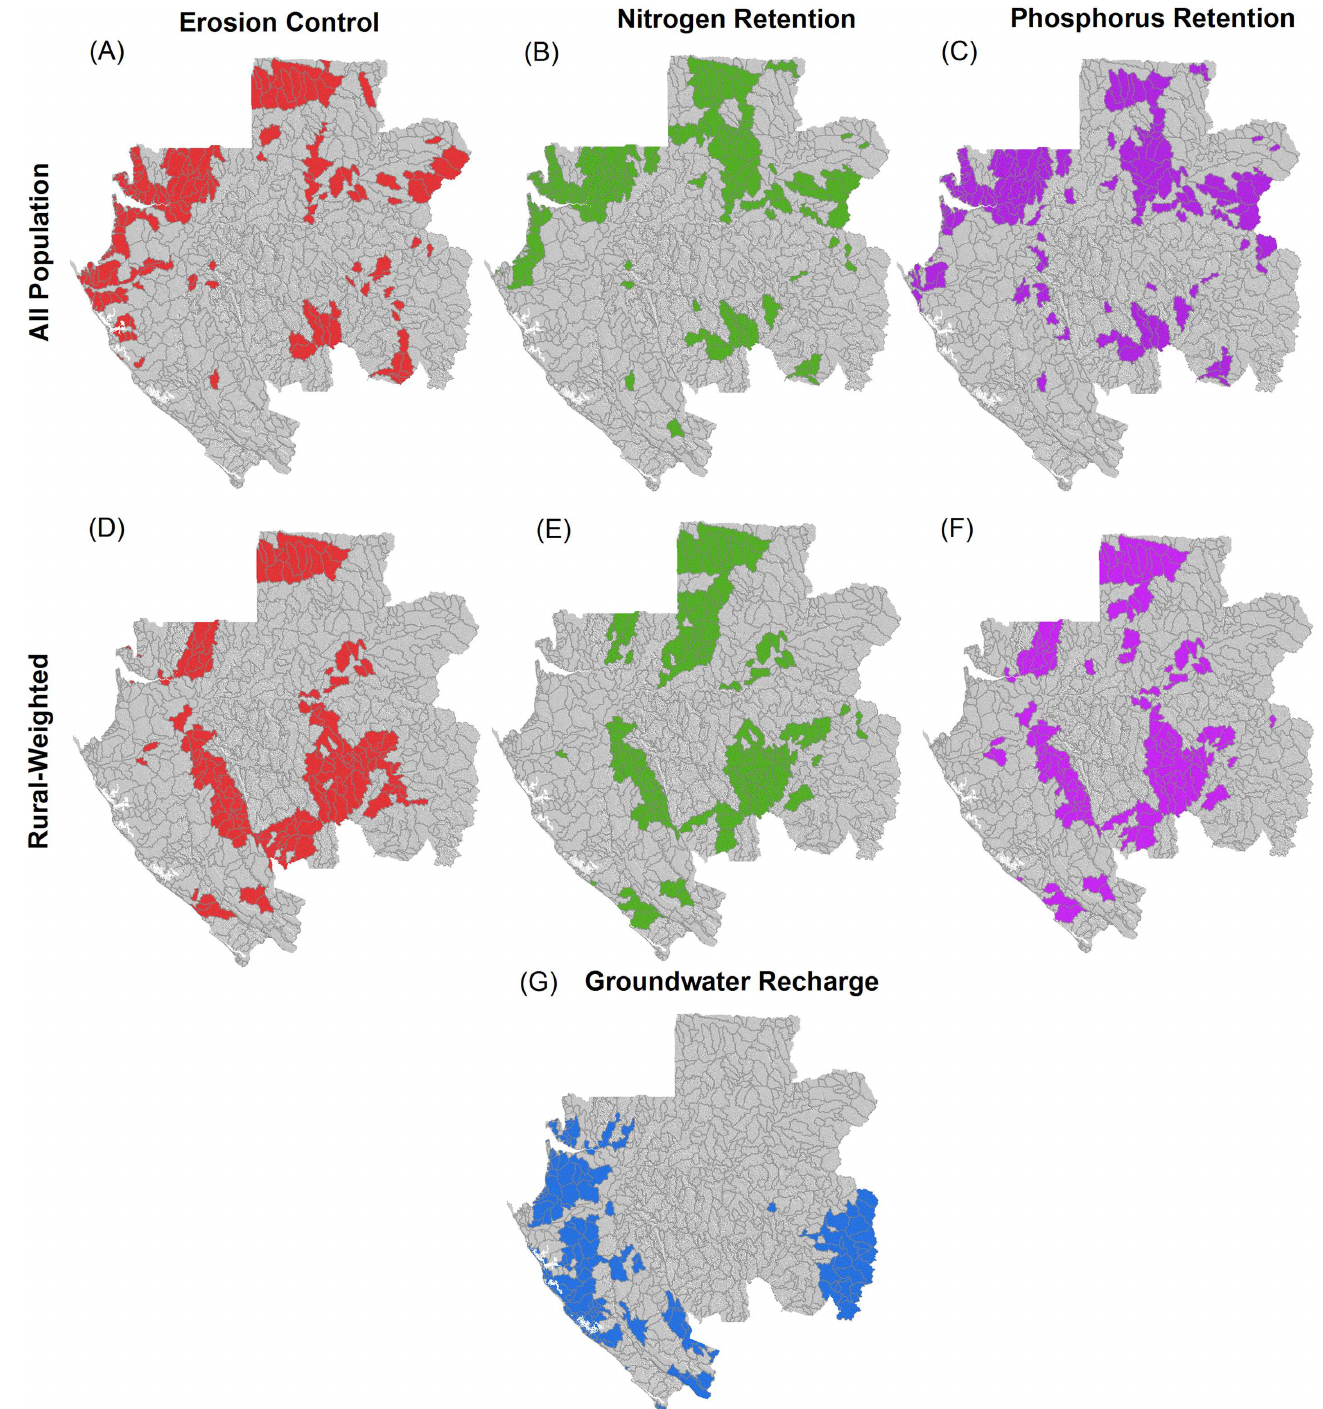
Fig 4. Priority areasof sub-watersheds (top 20% by area) for each hydrologic ecosystem service. (A-C) Erosion control, nitrogenretention, and phosphorous retention for the “all population” scenario.(D-F) Erosion control, nitrogenretention, and phosphorousretention for the “rural-weighted” scenario.(G) Groundwater rechargefor the singlescenario (i.e., not weightedby populationdistribution). Grey lines show the boundaryof all the sub- watershedpolygons.